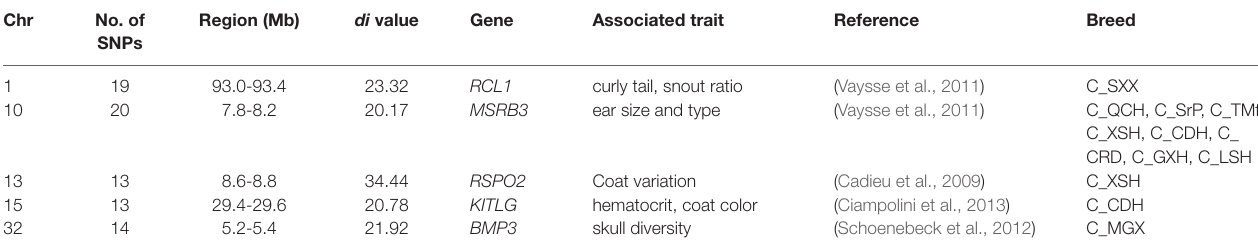
TaBle 2 | The windows showing signatures of selection sweep and including genes responsible for dog